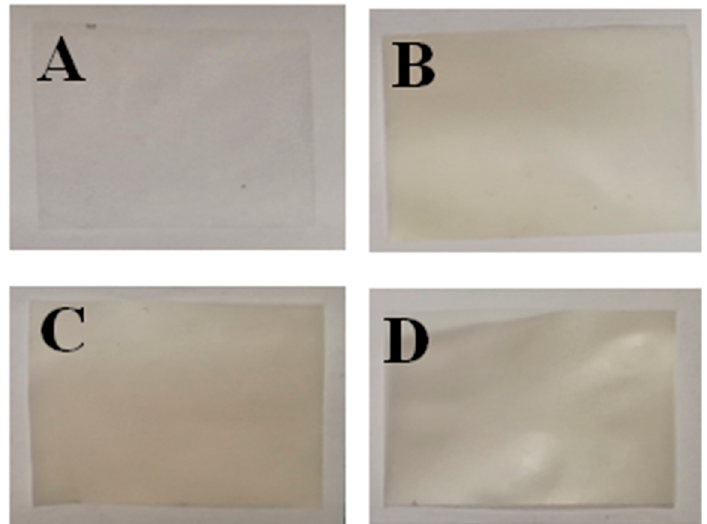
Figure 1. The images of four films ( A ) pure SA membrane; ( B ) SA/CW composite membrane; ( C ) SA/CW/G composite membrane; ( D ) SA/CW/G/Vc-Ca composite membrane).